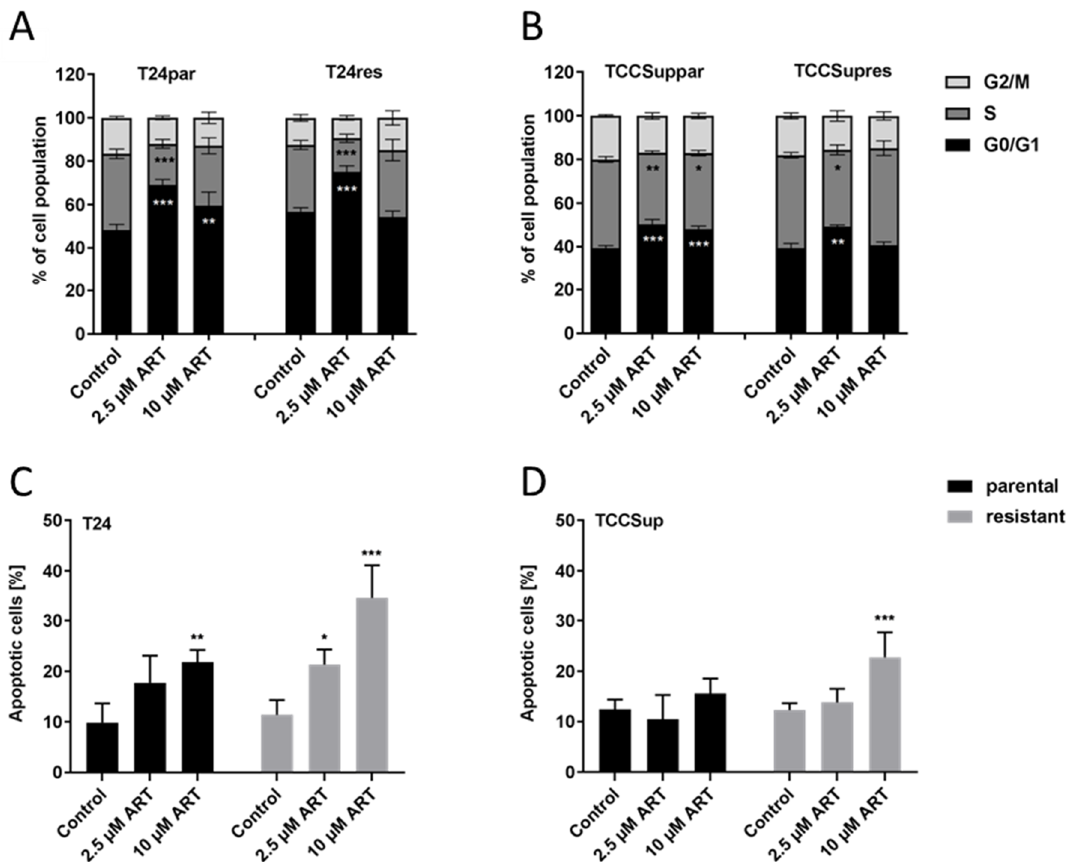
Figure 3. Distribution in the cell cycle phases and apoptotic events: Distribution in the cell cycle phases G2/, S, GO/G1) of parental and cisplatin-resistant T24 ( A ) and TCCSup ( B ) cells after 48 h (TCCSup) or 72 h (T24) exposure to ART. Percent of apoptotic events in parental and resistant T24 ( C ) and TCCSup ( D ) cells after 72 h treatment with ART (2.5 and 10 µM); comparison is to untreated controls. Error bars indicate standard deviation ( SD ). Significant difference to untreated control: * p ≤ 0.05, ** p ≤ 0.01, *** p ≤ 0.001. n = 4.